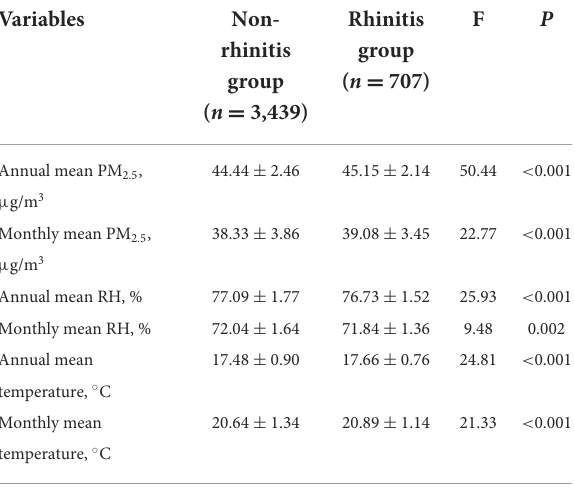
TABLE 3 ORs and 95% CI of environmental exposure for allergic rhinitis.